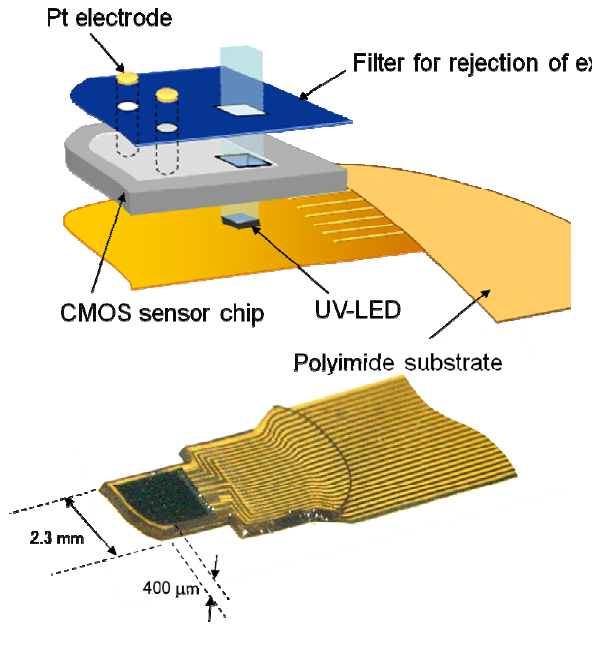
Figure 15. Schematic diagram of an implantable CMOS-based imaging device (adapted from